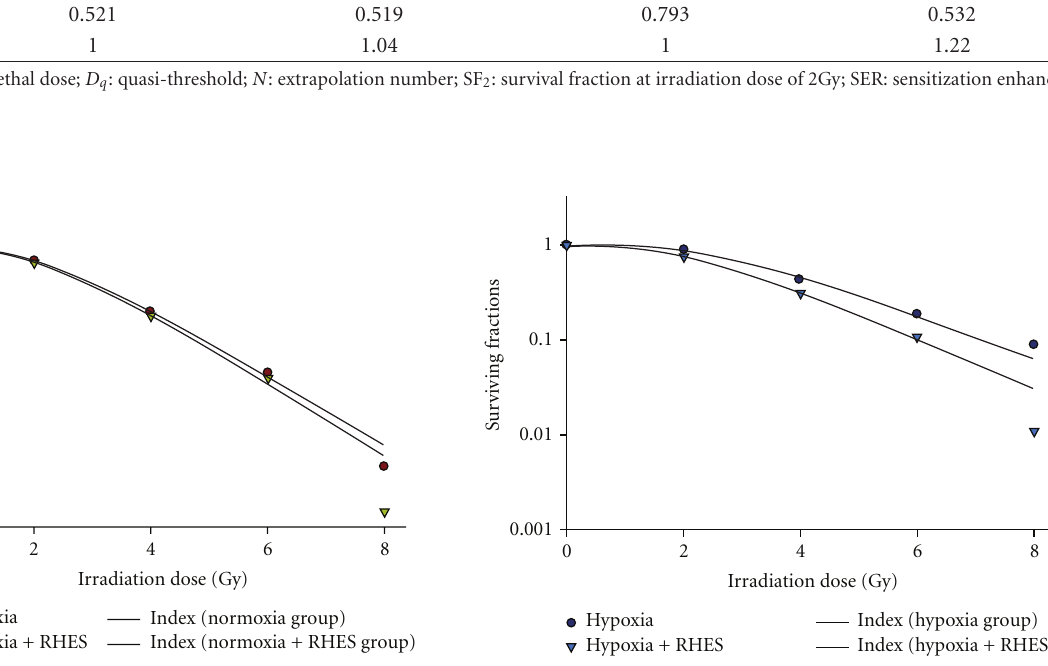
Figure 1: Cell survival curves of A549 cells under normoxia. Figure 2: Cell survival curves of A549 cells under